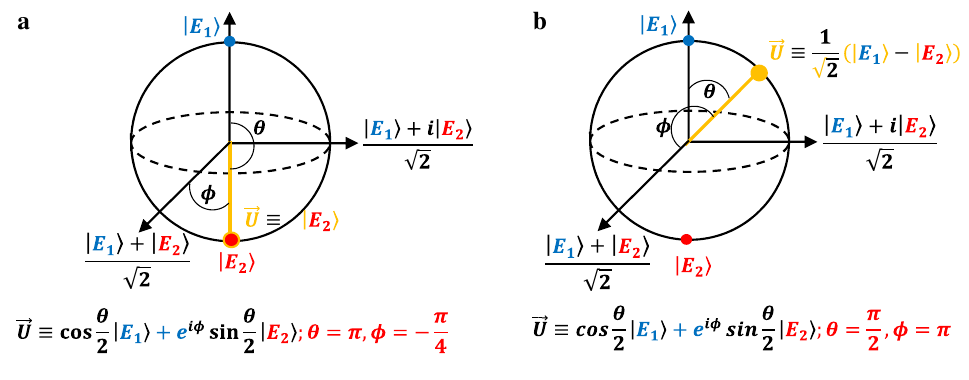
Figure 2. Classical analogue of Hadamard gate on Bloch sphere. The Hadamard gate ‘rotates’ the initial pure E 2 state of (a) (also labeled (i) in Fig. 1d right panel) to a superposition of states (b) (also labeled (ii) in Fig. 1d | � right panel) through a unitary transformation 1